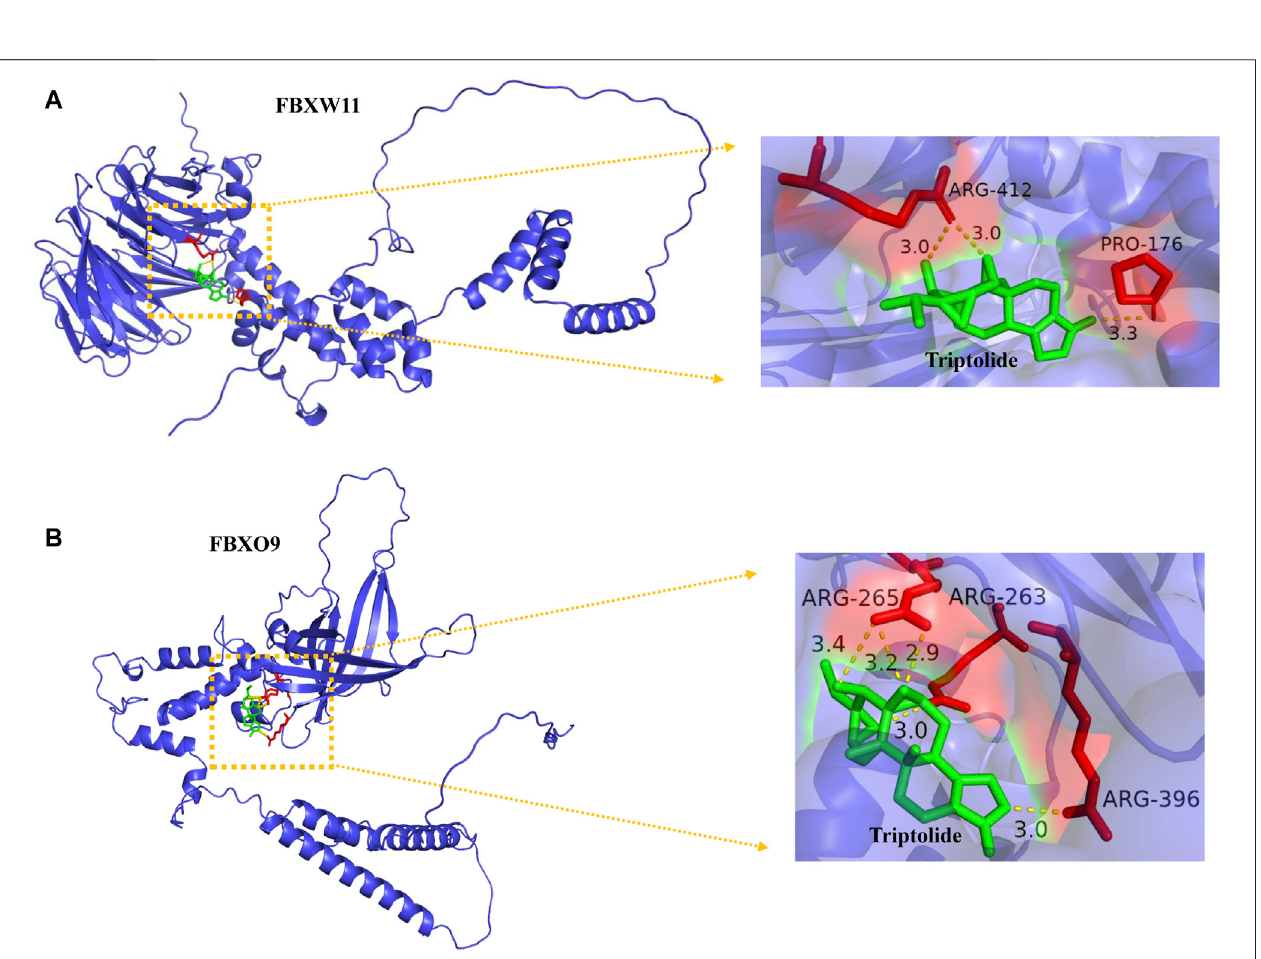
FIGURE6| Binding oftriptolide tothecoretargetFBXW11, and FBXO9 using molecular docking analysis. (A) Hydrogenbond sitesformed betweentriptolideand FBXW11 protein on ARG-412 and PRO-176. (B) Hydrogen bond sites formed between triptolide and FBXO9 protein on ARG-265, ARG-263, and ARG-396. Green represents triptolide, while red represents amino acid residue binding sites.